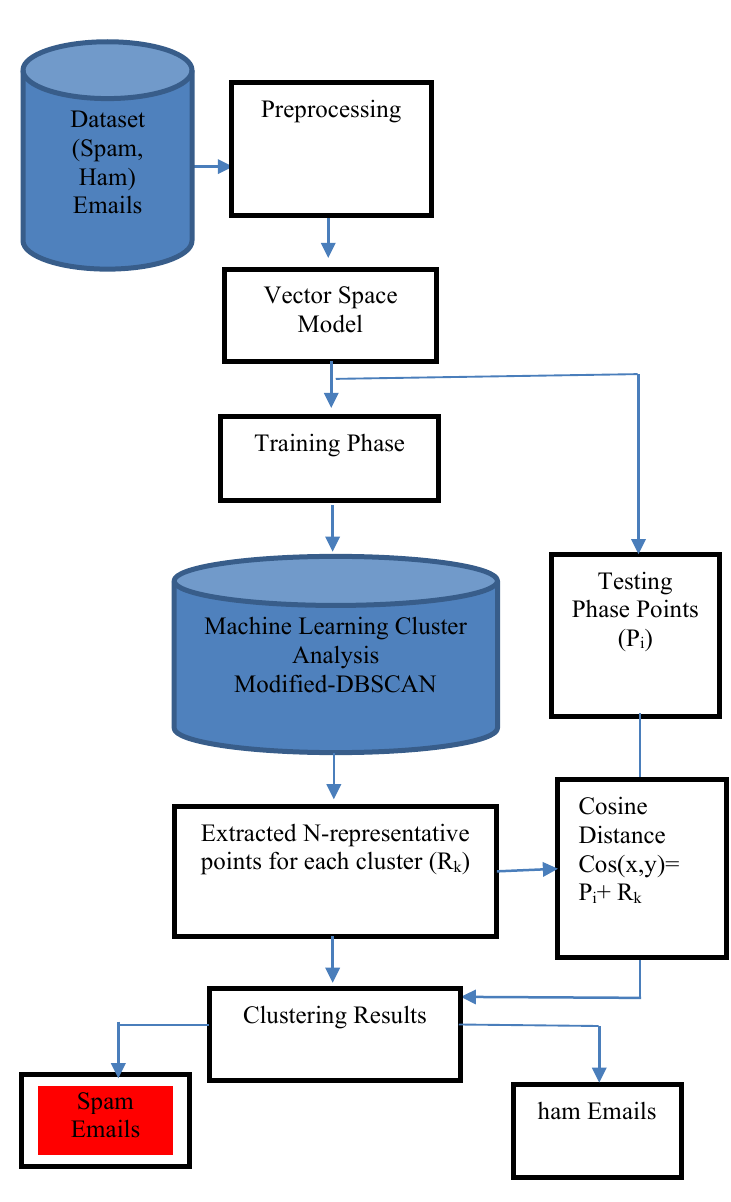
Figure 3. The proposed spam detection system The dataset source has been from the